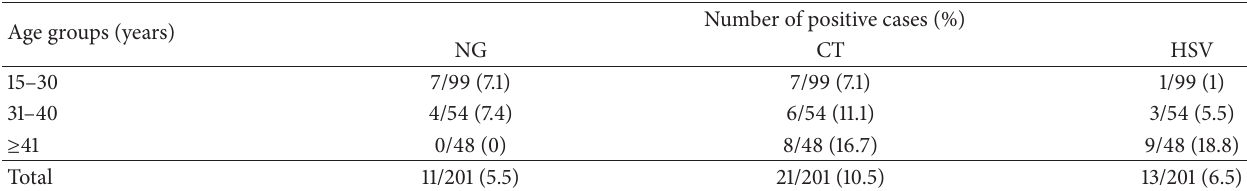
Table 2: Prevalence of Herpes simplex virus (HSV), Chlamydia trachomatis (CT), and Neisseria gonorrhoeae (NG) in different age groups among married Women, Dubai,